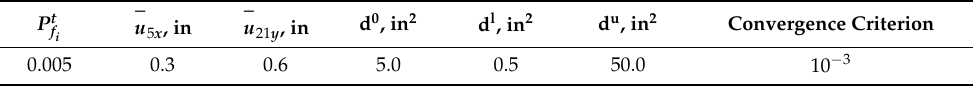
Table 14. Target failure probability and parameters for the reliability analysis and optimization. P t f i